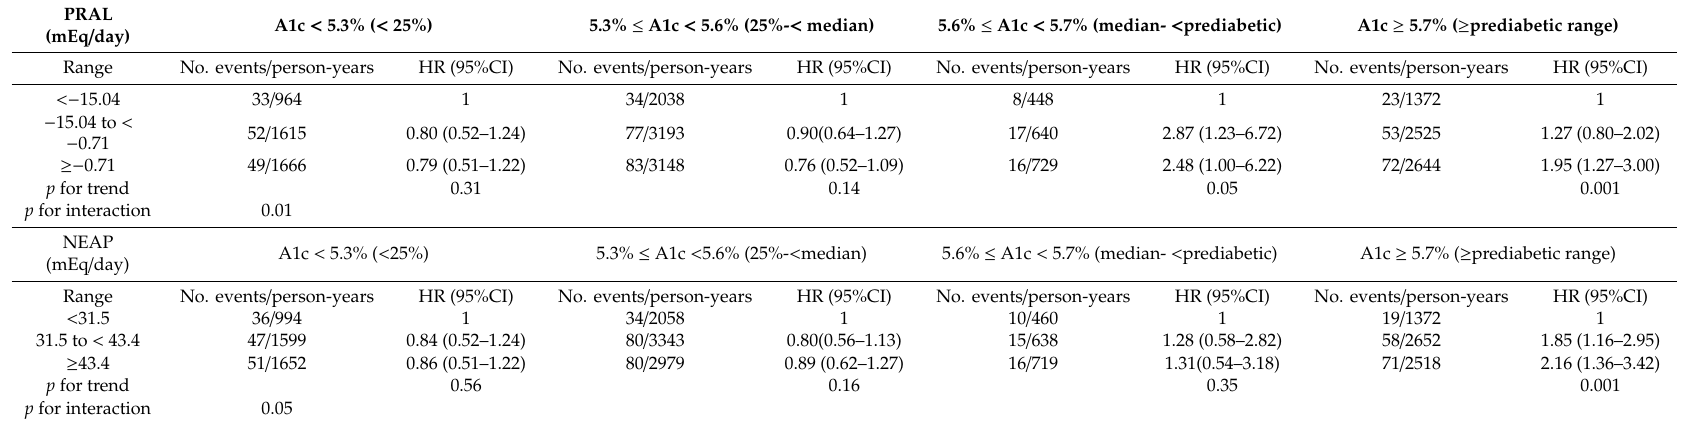
Table 4. Multivariable-adjusted associations between dietary acid load and breast cancer recurrence according to levels of hemoglobin